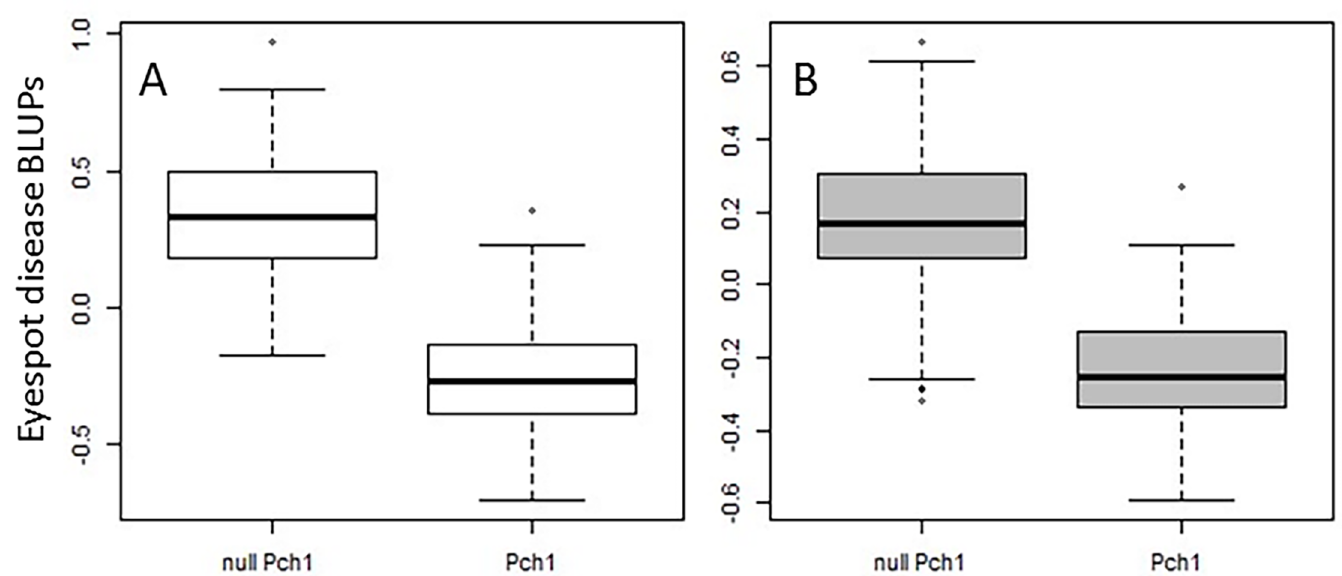
Fig 3. Boxplots of eyespot disease BLUPs for all winter wheat lines without Pch1 (null Pch1) and all lines with Pch1 resistance allele ( Pch1) in Panel A (A) and Panel B (B).